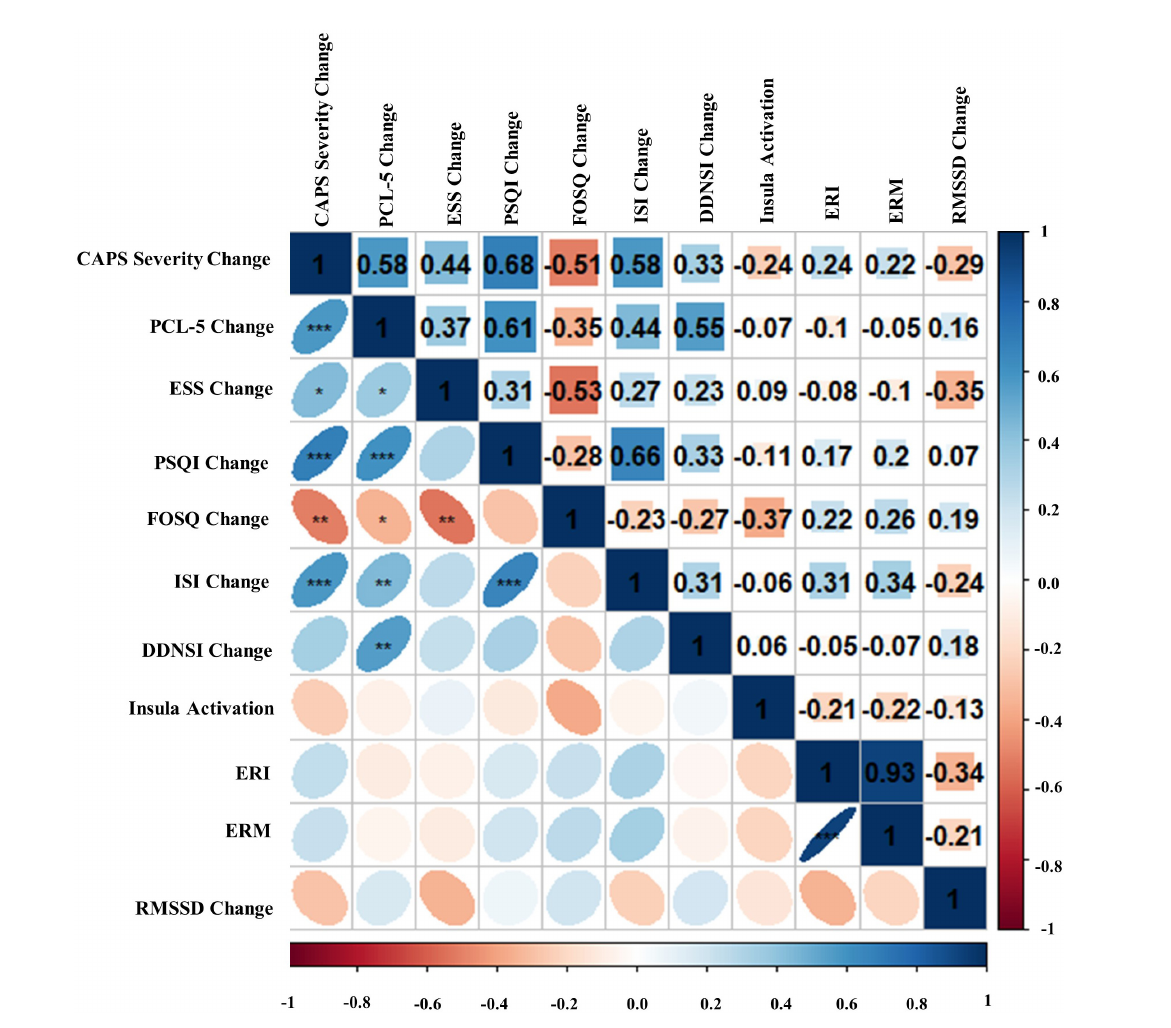
FIGURE8 Bivariate Pearson correlations were performed across Blue Light Treatment (BLT) subjects with correlation coefficients in the upper portion of the matrix and significant correlations identified in the lower portion of the matrix. Change represents residualized change scores. * p < 0.05, ** p < 0.01, *** p < 0.001. Clinician-Administered PTSD Scale for DSM-5 (CAPS-5), PTSD Checklist for DSM-5 (PCL-5), Epworth Sleepiness Scale (ESS), Pittsburgh Sleep Quality Index (PSQI), Functional Outcomes of Sleep Questionnaire (FOSQ), Insomnia Severity Index (ISI), Disturbing Dreams and Nightmares Severity Index (DDNSI), Extinction Recall Index (ERI), Extinction Recall Magnitude (ERM), Root Mean Square of Successive Differences